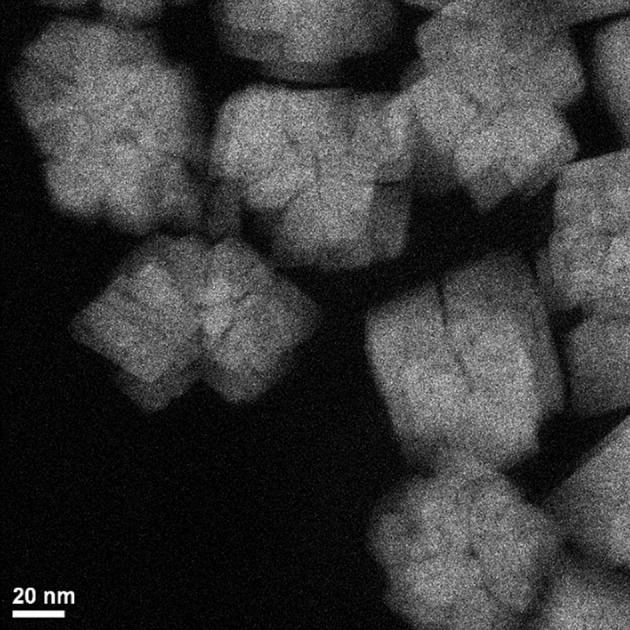
TEM image showing grain boundary consolidation in f-CoO nanoparticles.